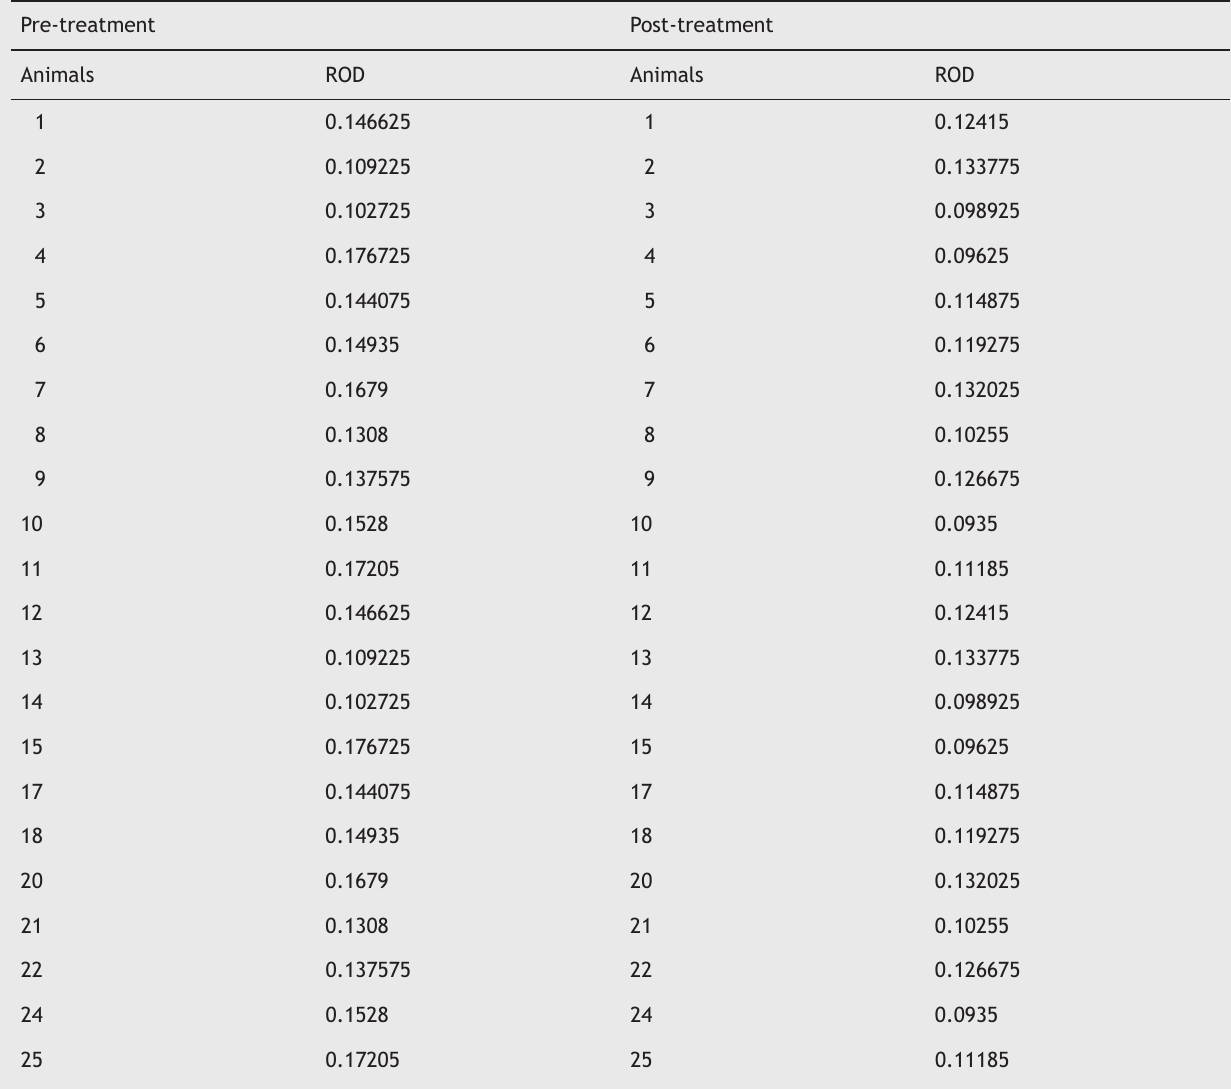
Table 1 Optical density of slides before and after estradiol treatment.